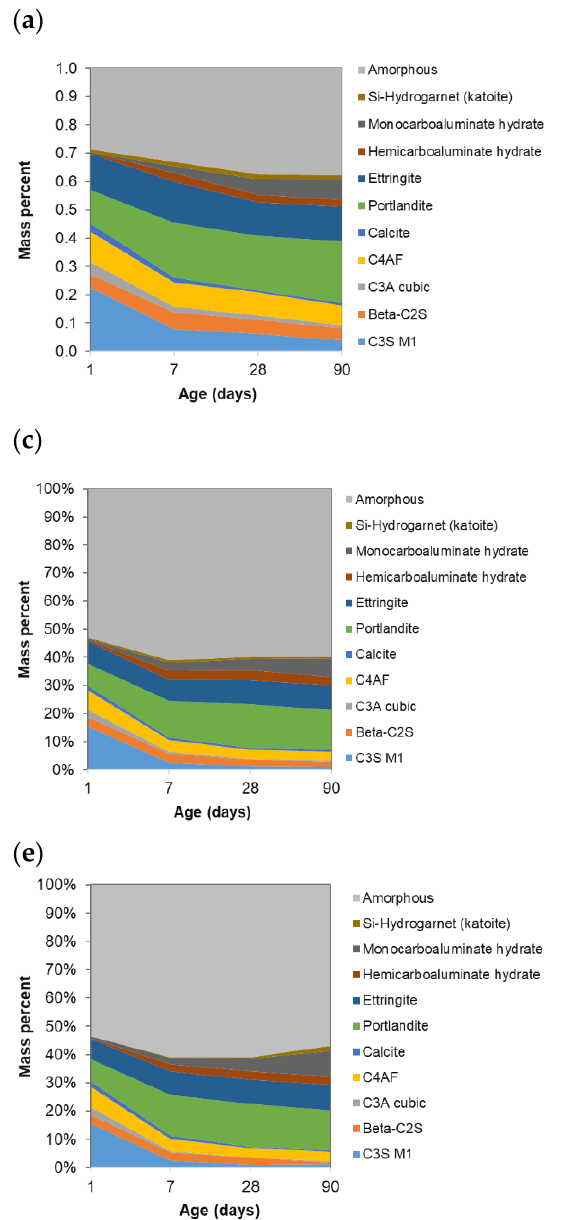
Figure 6. Area charts displaying the evolution of different phases over time; values in g/100 g of binder. ( a ) P_PC, ( b ) P_QP, ( c ) P_TS1, ( d ) P_TS2 and ( e ) P_TS3.